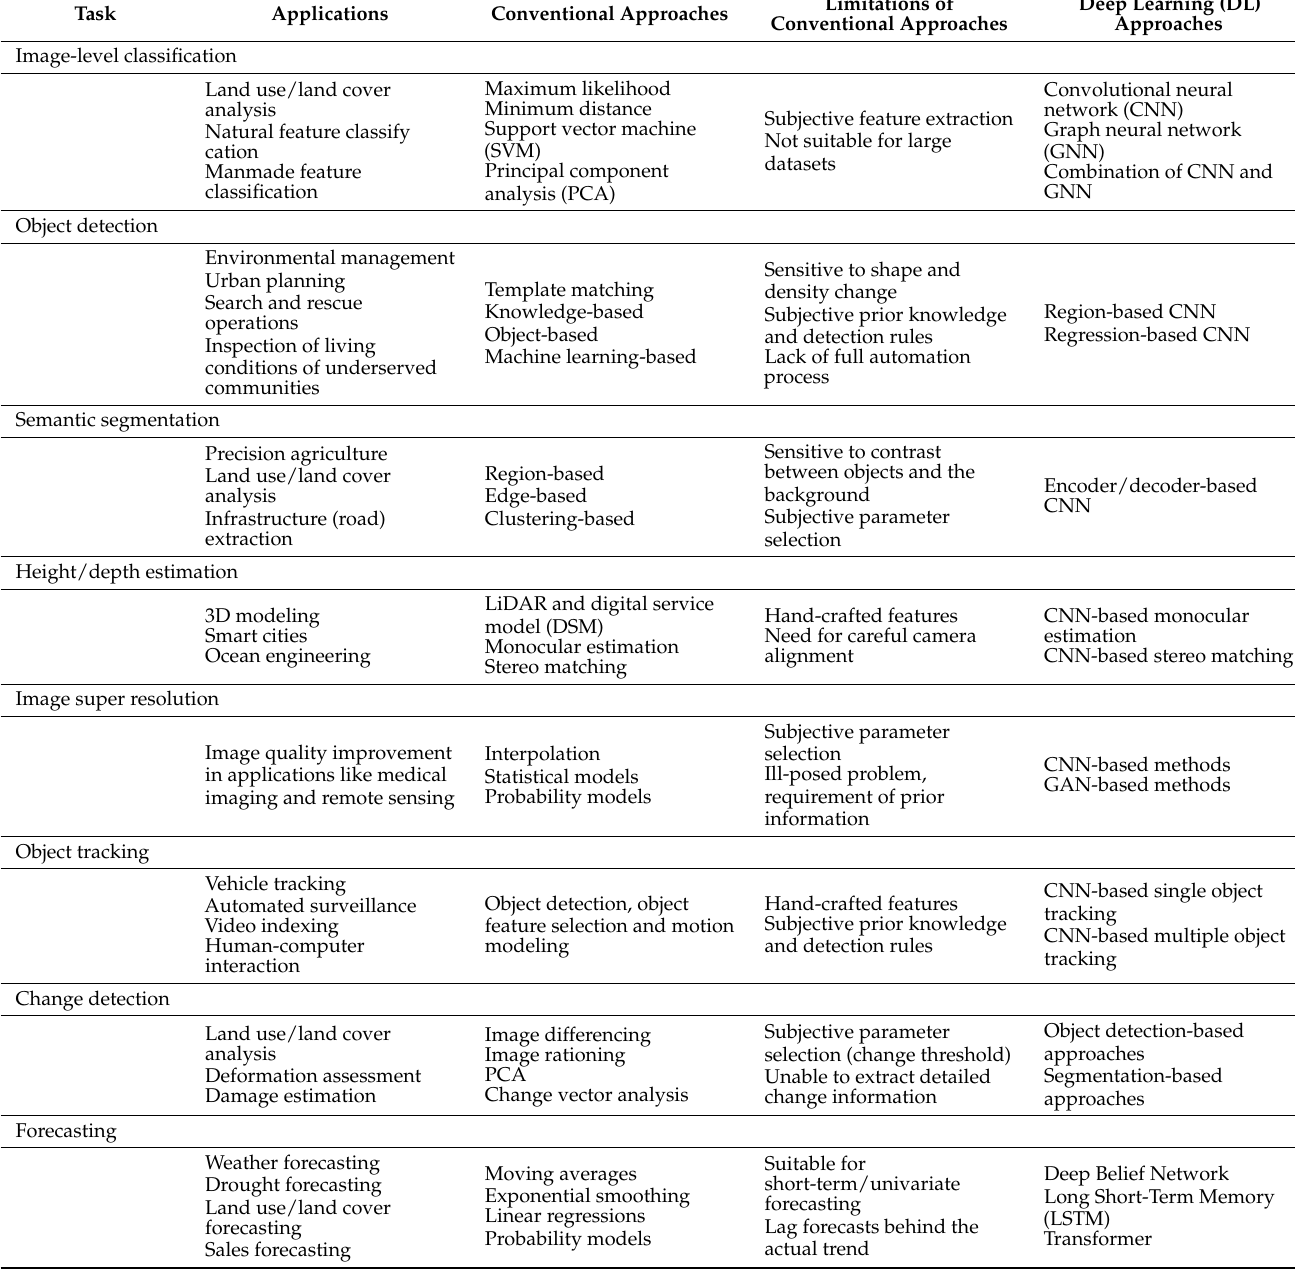
Table 1. Summary of GeoAI and deep learning applications in remote sensing image